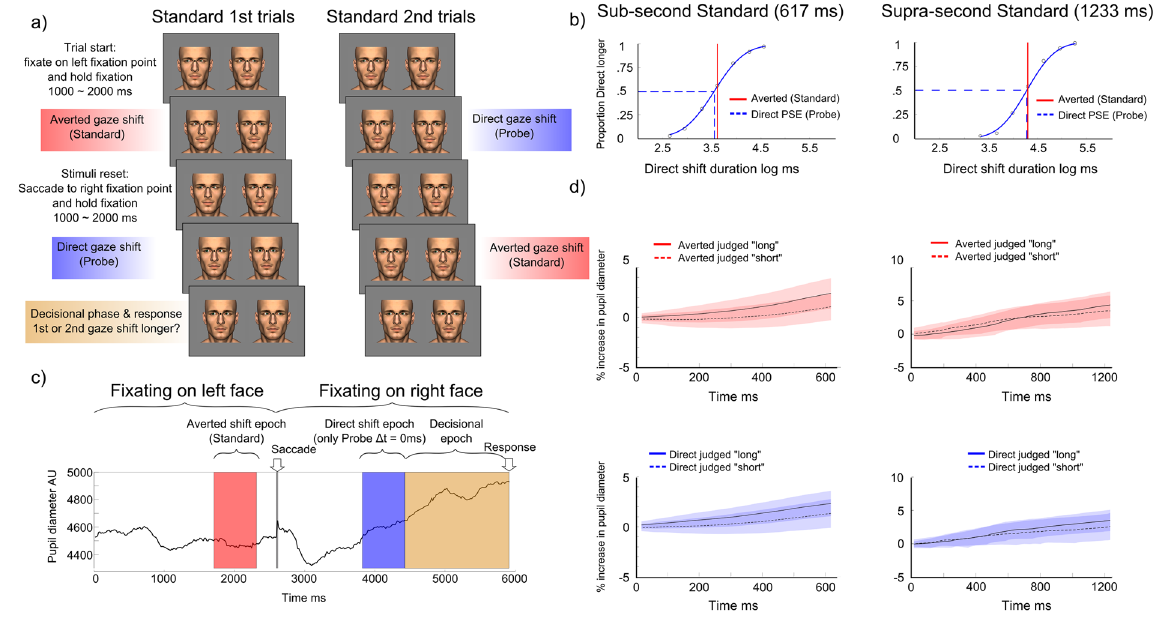
Figure 1. ( a ) Gaze shifts were performed by the left avatar first, and the right avatar second. Participants saccade from the left to the right fixation point when the left avatar has reset to its starting position following its gaze shift. The order of direct and averted shifts was counterbalanced across trials, so on half the trials the left avatar performed an averted shift and then the right avatar performed a direct shift (Standard 1 st trials), while in the remaining half the left avatar performed a direct shift and then the right avatar performed an averted shift (Standard 2 nd trials). ( b ) Group average psychometric functions for sub and supra-second standards. The Point of Subjective Equality (PSE – blue dotted line) indicates the duration required for a Direct gaze shift to appear equally long to an Averted gaze shift. The red solid line represents the standard duration. ( c ) Pupil signal segmentation into Direct & Averted duration encoding epochs and the ensuing decisional epoch in a “Standard 1 st ” trial. ( d ) Pupil signal response type comparison during the direct and averted duration encoding epochs. We directly compared pupil responses across identical stimuli that lead to opposite duration classifications. Shaded error plots show averaged increase in pupil diameter across time during gaze shifts of identical physical duration classified as “long” or classified as “short”. Avatar stimuli created with Poser 9 software (SmithMicro